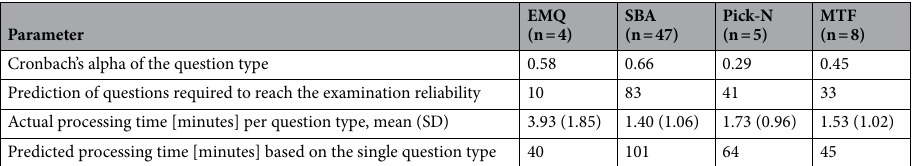
Table 3. Reliability analyses and prediction using the Spearman-Brown